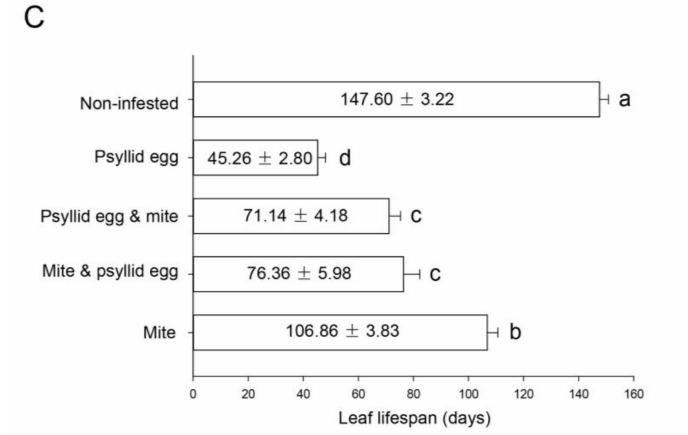
Figure 3. Habitat selection preferences for A. pallida and B. gobica . ( A ) On mite-infested or non- infested seedlings, mean numbers of psyllid eggs on leaves with and without mites; ( B ) On psyllid- infested or non-infested seedlings, mean numbers of mites on leaves with and without psyllid eggs. Asterisks (*) indicate a significant difference in the number of psyllid eggs (mites) on non-infested leaves between mite-infested (psyllid-infested) and non-infested seedlings ( χ 2 tests, p < 0.05). ( C ) The lifespan of leaves only infested with mites, leaves infested with mites and psyllid eggs (mite & psyllid egg, infested by mites first; psyllid egg & mite, invaded by psyllid eggs first), leaves only infested with psyllid eggs, and non-infested leaves. Different letters indicate significant differences among the treatments (mean ± SE; mean separation by Tukey’s HSD, p <